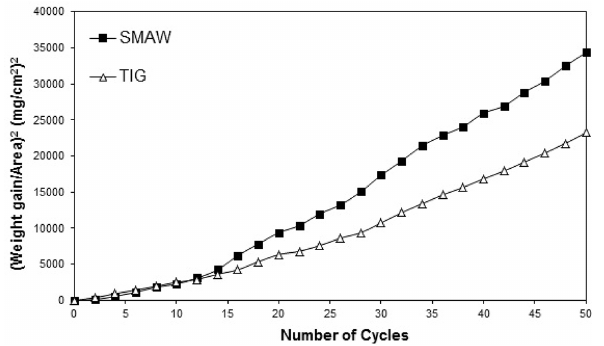
Figure 2: Weight gain square (mg/cm 2 ) 2 plot for welded steels exposed to air at 900°C.